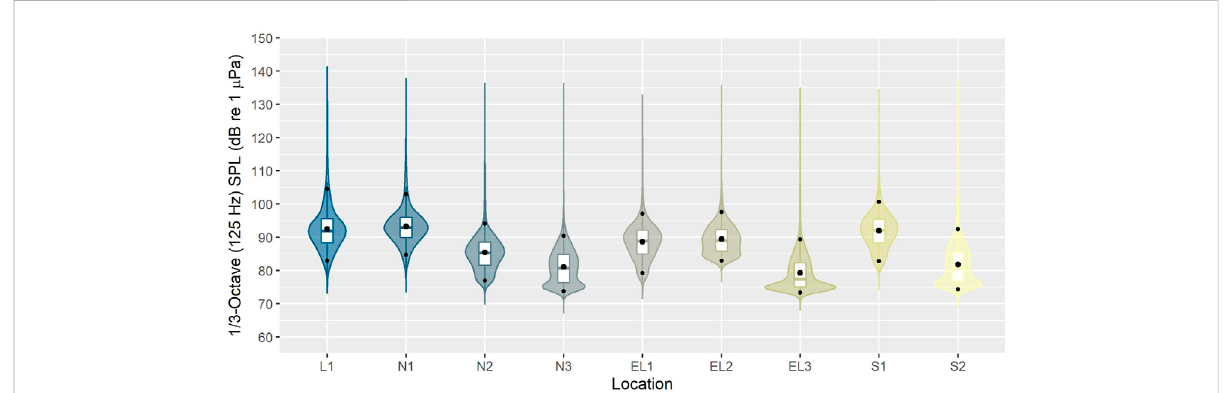
FIGURE 7 Root-mean-squaresoundpressurelevel(L p ,rms ;dBre1 μ Pa)distributionsforthe1/3-octavebandcentredat125 Hzacrossthewholerecording period (i.e. 8 – 12 months; see Table 1), plotted by site (see Figure 1). Lower and upper bounds of boxes represent lower and upper quartiles, respectively. Solid middle box lines represent the median and the larger black dot the mean. Small black dots indicate the 5th and 95th percentiles. The probability distribution of the data is shown as kernel density.